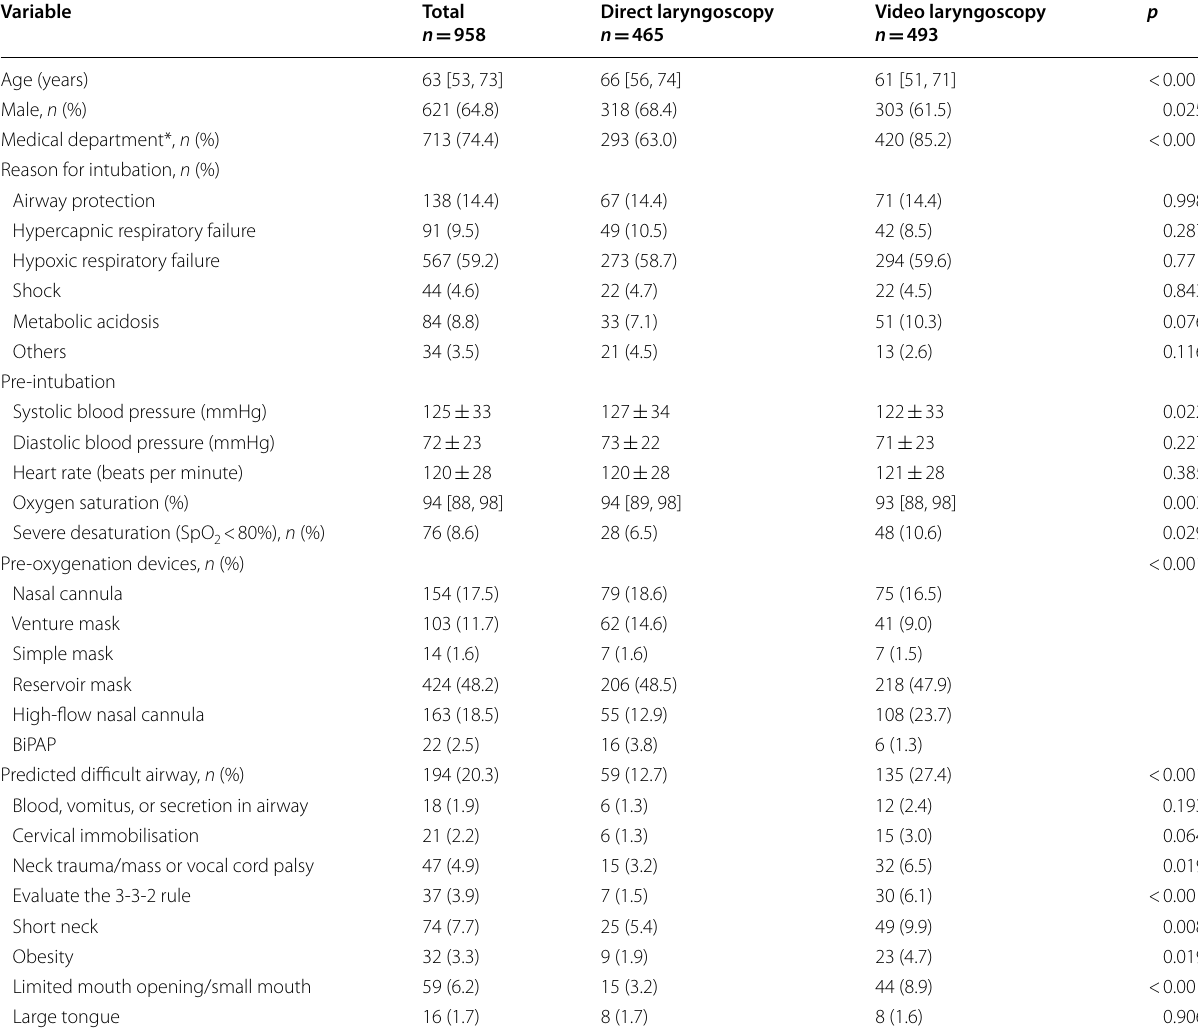
Table 1 Baseline clinical characteristics of the patients according to intubation